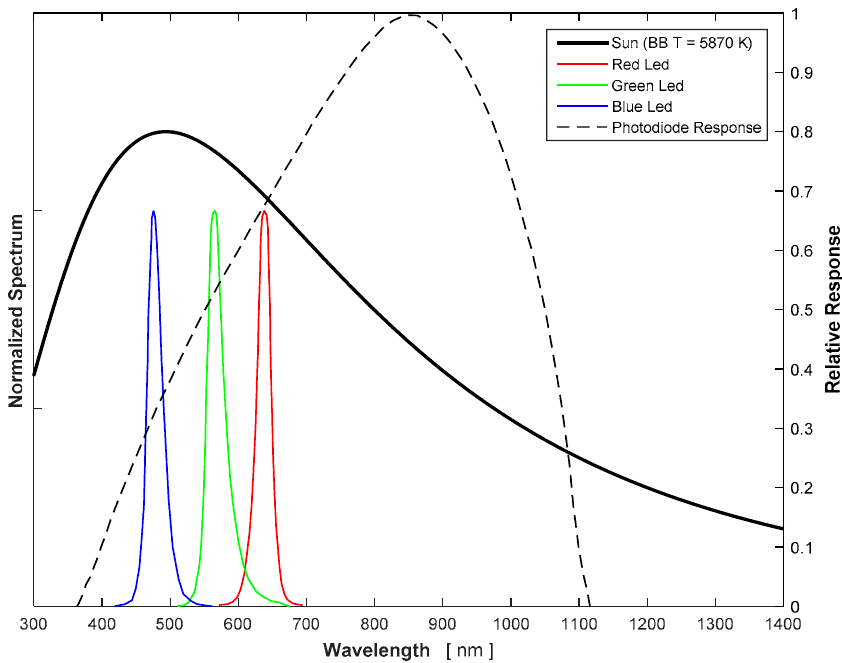
Figure 7. Typical spectrum of different light sources and the photodiode response.